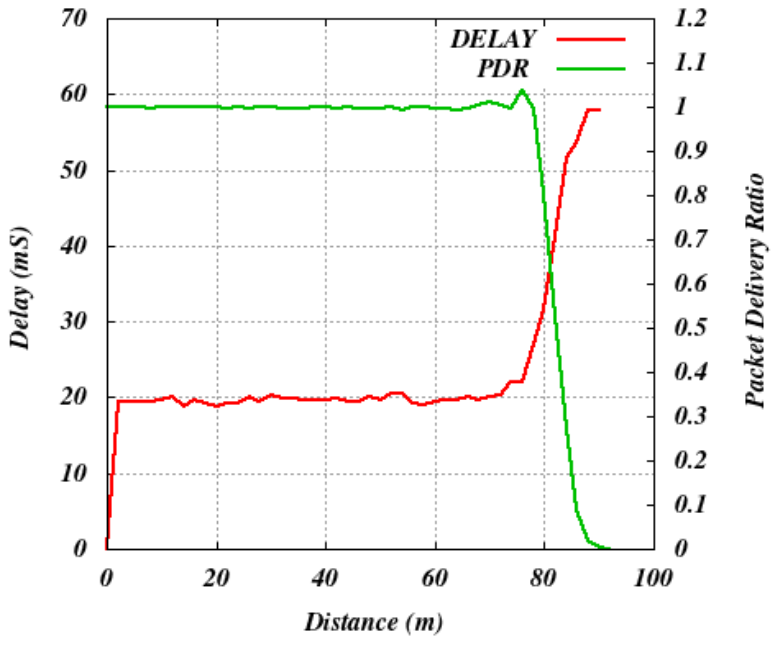
Figure 12. Average delay overhead, packet delivery ratio vs. distance.